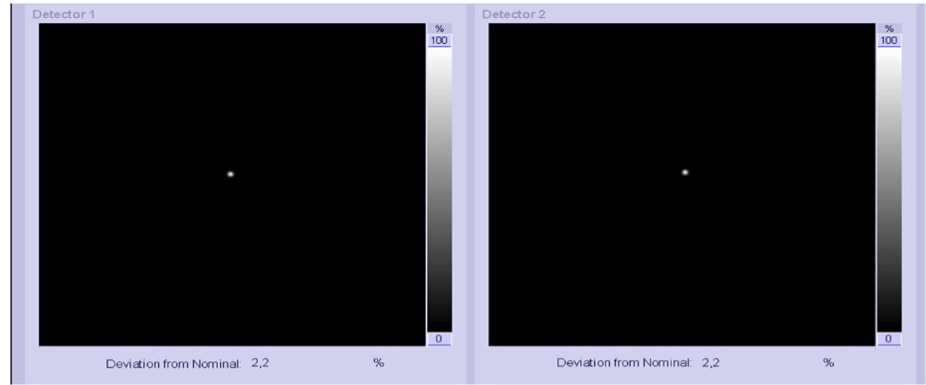
Figure 5. Planar images obtained from the system calibration with the 57 Co point source .